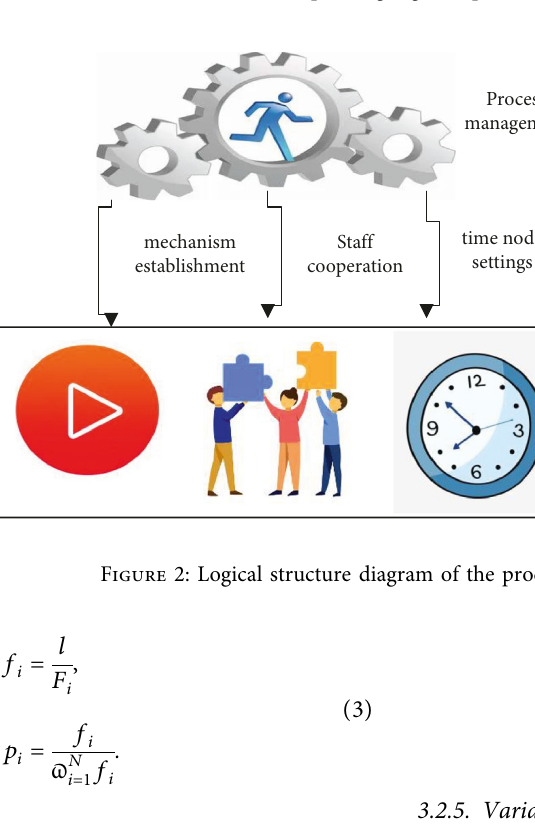
Figure 1: Operating logic map of the link.